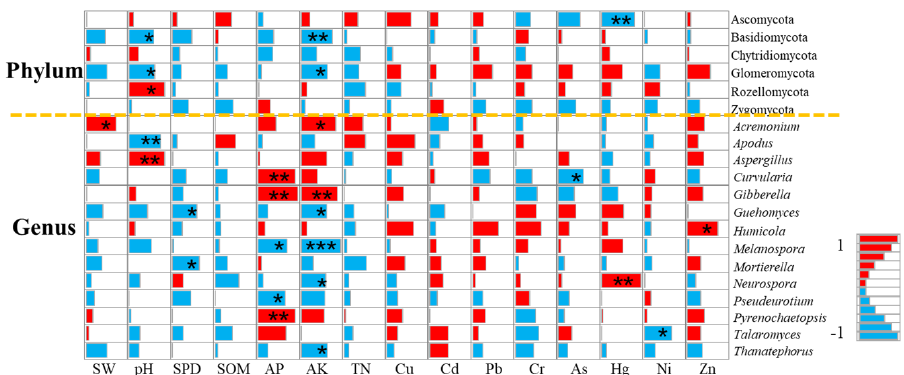
Figure 16. Correlation between soil environmental factors and fungal community structure at moderate levels of heavy metal pollution. (Note: In the figure, warm colors indicate positive correlation, and cool colors indicate negative correlation. *, **, *** indicate significant correlation at the levels of 0.05, 0.01, and 0.001, respectively).